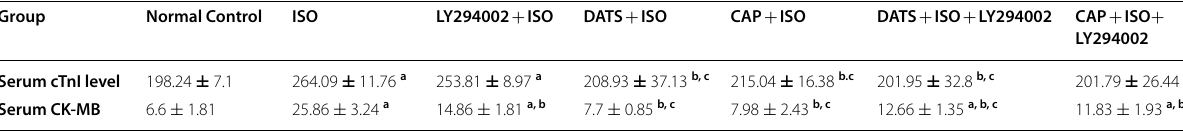
Data are presented as mean SD, significance was set at P < 0.05, n ± (0.3 mg/kg/d), DATS ISO: Diallyl trisulfide pretreated group (40 mg/kg d), CAP + and PI3K inhibitor pretreated group, CAP